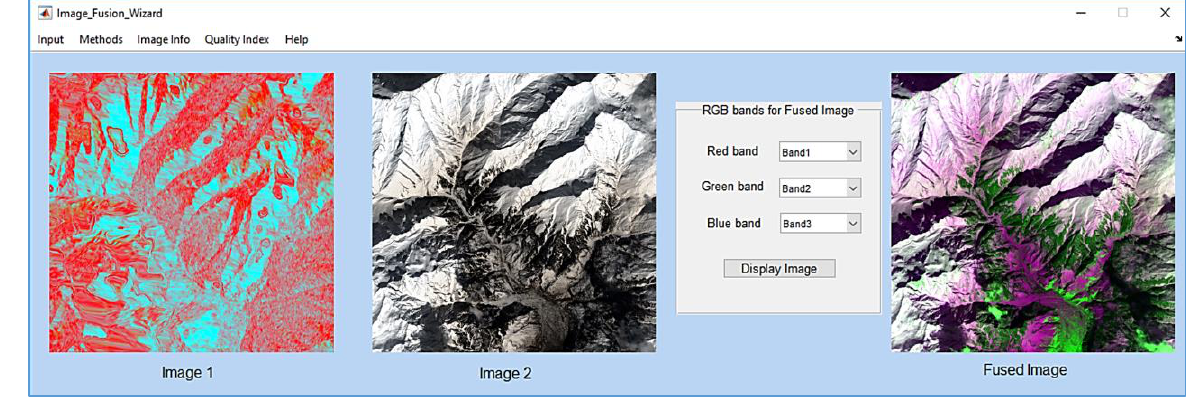
Figure 5. Fusion of sentinel-1 texture image and H-α-decomposition image of Sentinel-1 using BDF